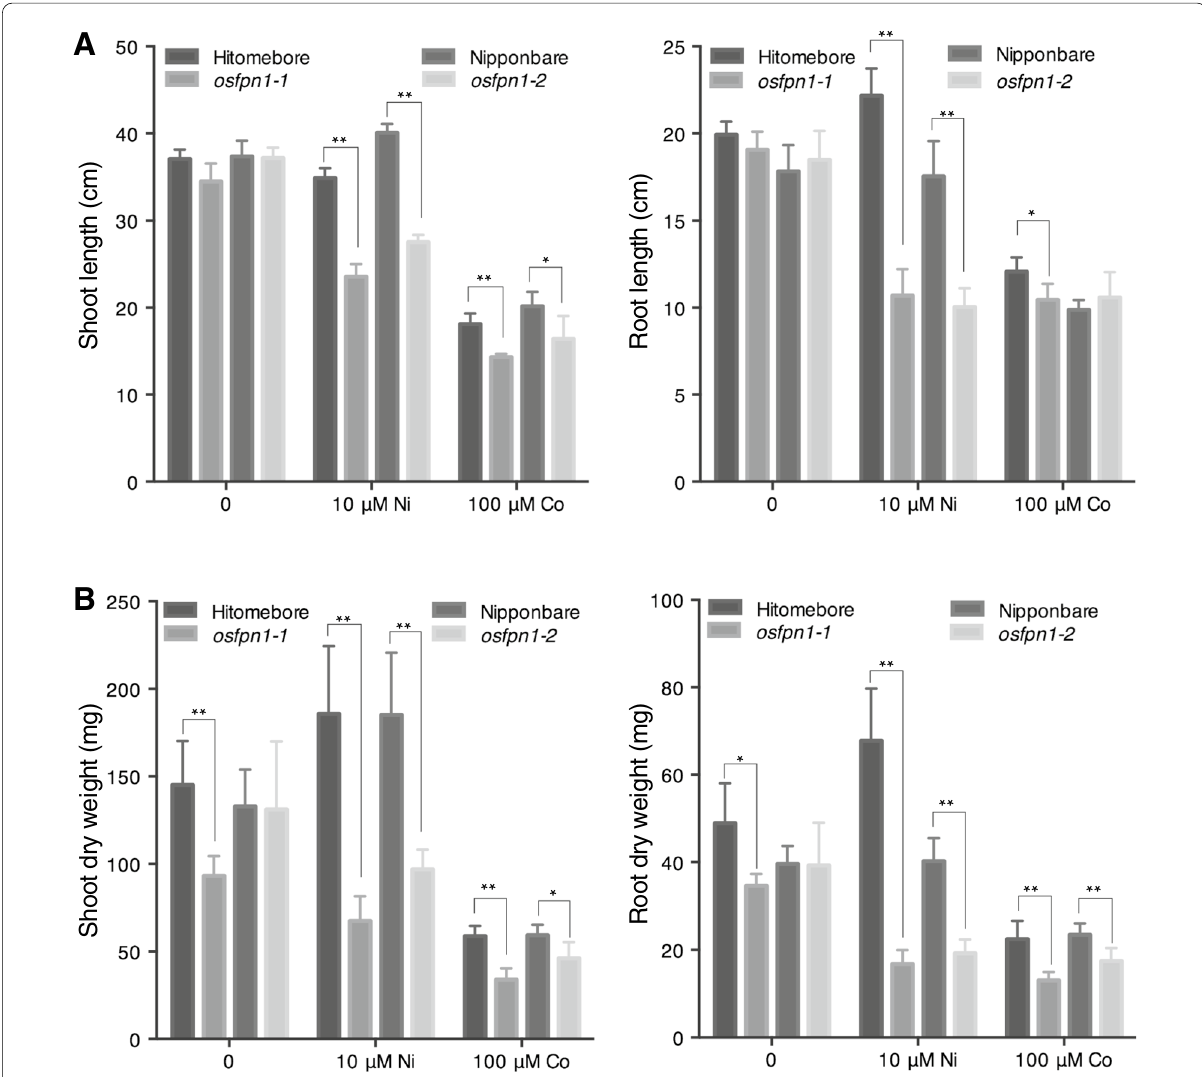
Fig. 4 Sensitivity of osfpn1-1 and osfpn1-2 to high Co and Ni. Shoot (left panel) and root (right panel) lengths ( A ) and dry weight ( B ) of one-week-old plants grown in Kimura B solution transferred without Co or Ni application, or 10 or 100-µM Ni application in Kimura B solution for two weeks. Data represent the means SD (n 5). Student’s t -test (compared to Hitomebore or Nipponbare). **p < 0.01, * p < ± =